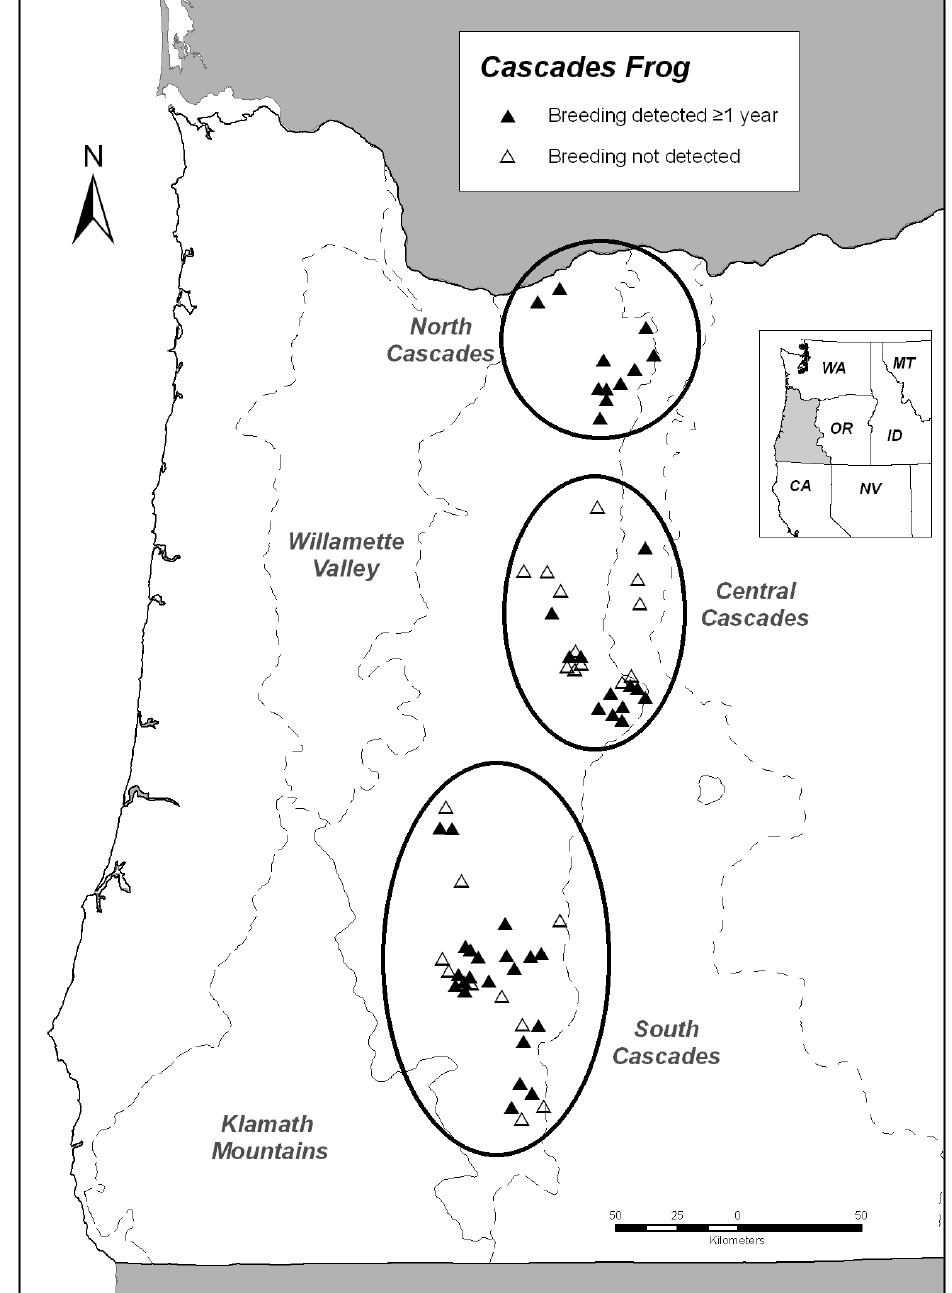
Figure 2. Historical breeding sites (N = 66) surveyed for R. cascadae in 2001–2004, Cascade Range, Oregon,